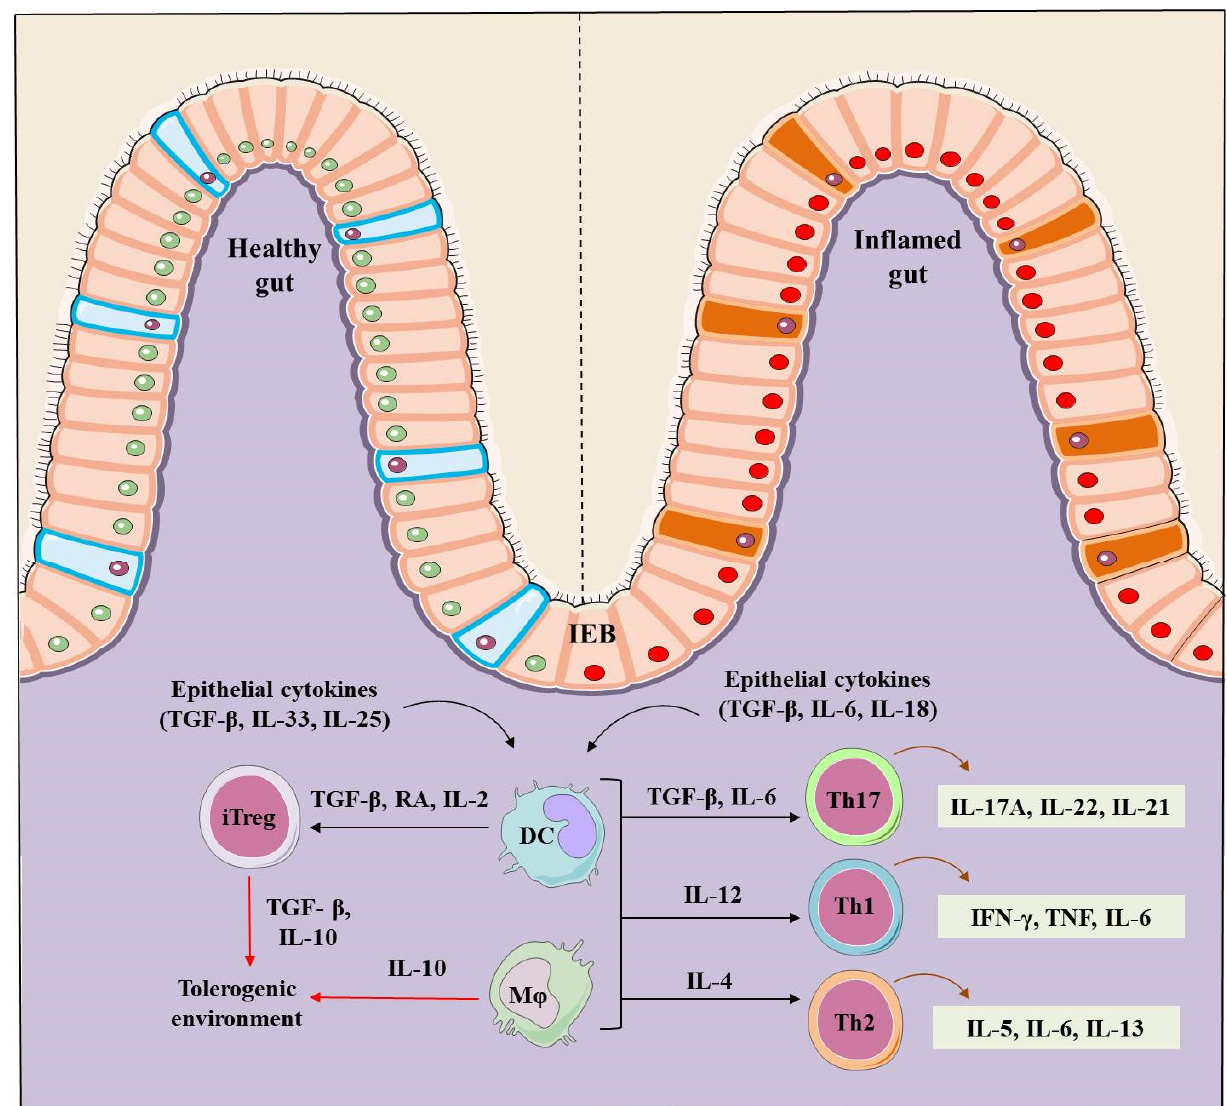
Figure 1. Regulation of the intestinal homeostasis in healthy and IBD inflamed gut. A healthy intestinal epithelial barrier (IEB) in presence of TGF- β , retinoic acid (RA) and IL-2 promote dendritic cells (DCs) and macrophages (m φ ) to stimulate the generation of inducible Trges (iTregs). TGF- β and IL-10 are markers that contribute to the generation of iTregs, and establish and maintain the tolerogenic environment in a healthy gut. On the contrary, IBD induced inflammation induces intestinal epithelial barriers and secrete TGF- β , IL-6 and IL-8, stimulating DCs and m φ to produce the inflammatory Th-17 (IL-17A, IL-22, IL-21), Th-1 (IFN- γ , TNF- α , IL-6) and Th-2 type cells (IL-5, IL-6, IL-13) creating an inflammation focus and diseased intestine.